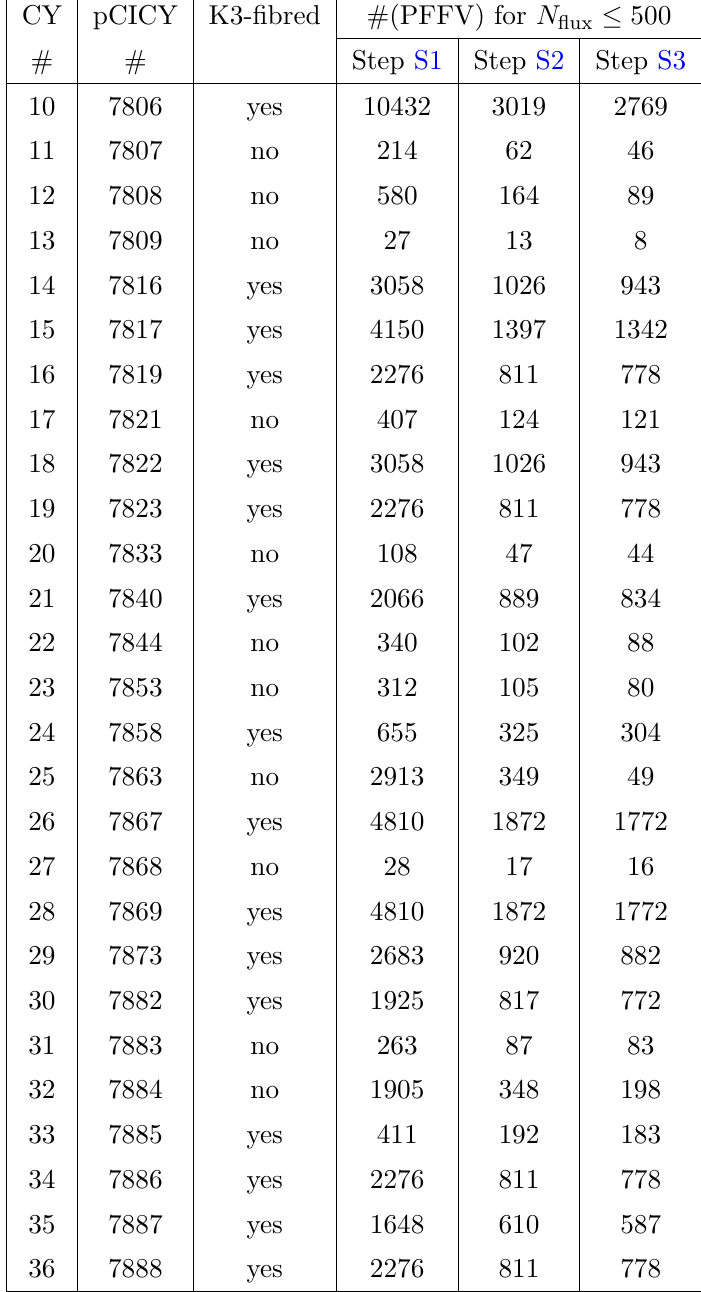
Table 2. Number of PFFV obtained after each of the three steps S1–S3, corresponding to N flux ≤ 500 . The second column is the number of the pCICY as in [26]. From now on, we will omit this number, and we refer to the pCICY using the first